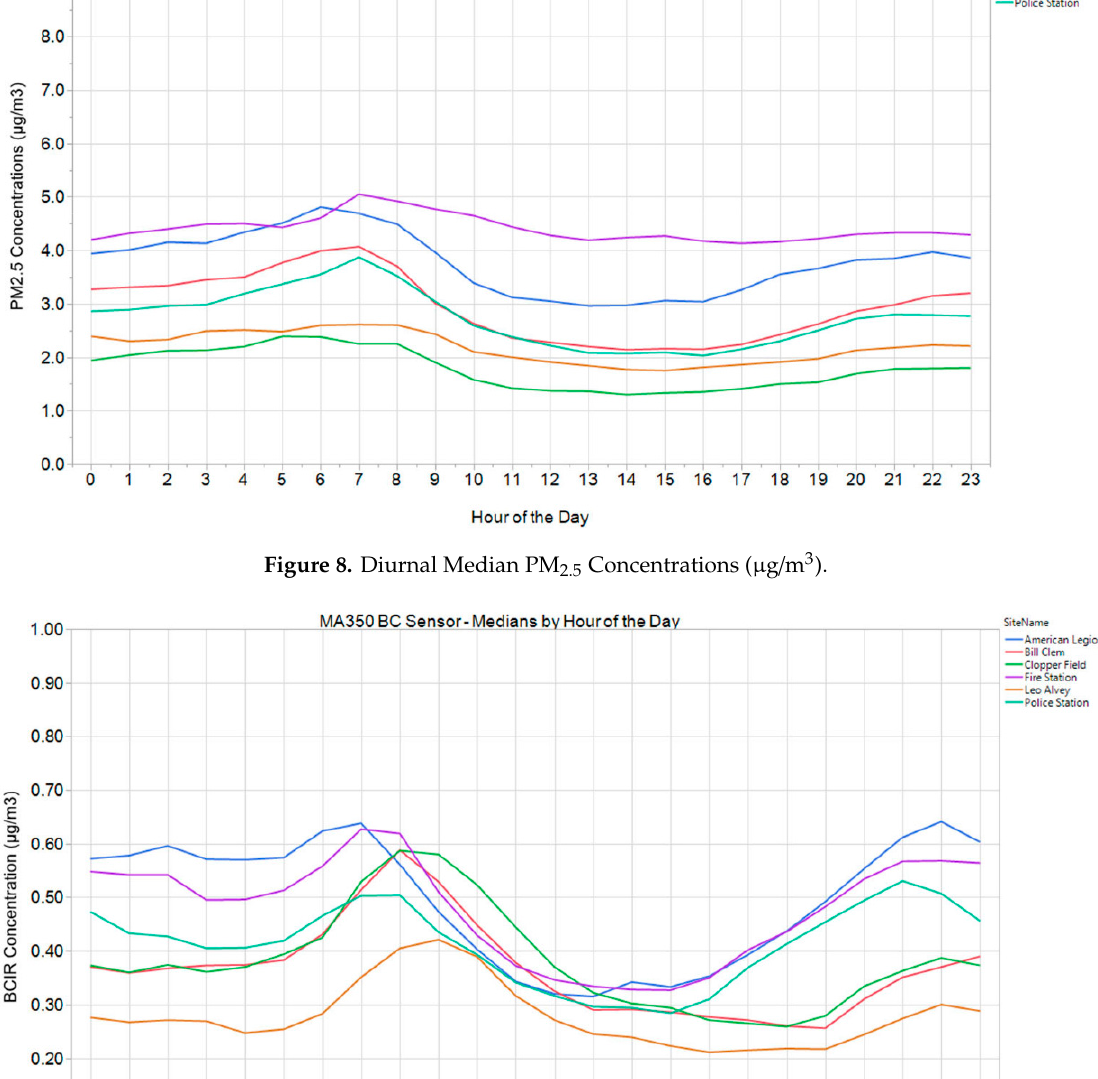
Figure 8. Diurnal Median PM 2.5 Concentrations (µg/m 3 ).